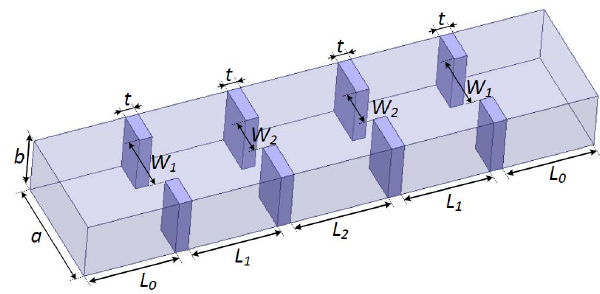
Figure 3. Geometrical variables and 3D configuration of the three-order waveguide filter example.